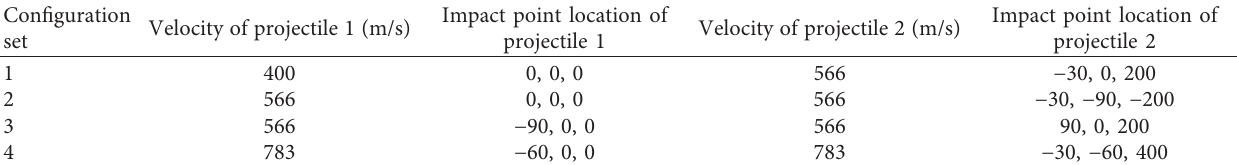
Table 5: Configuration for FEM